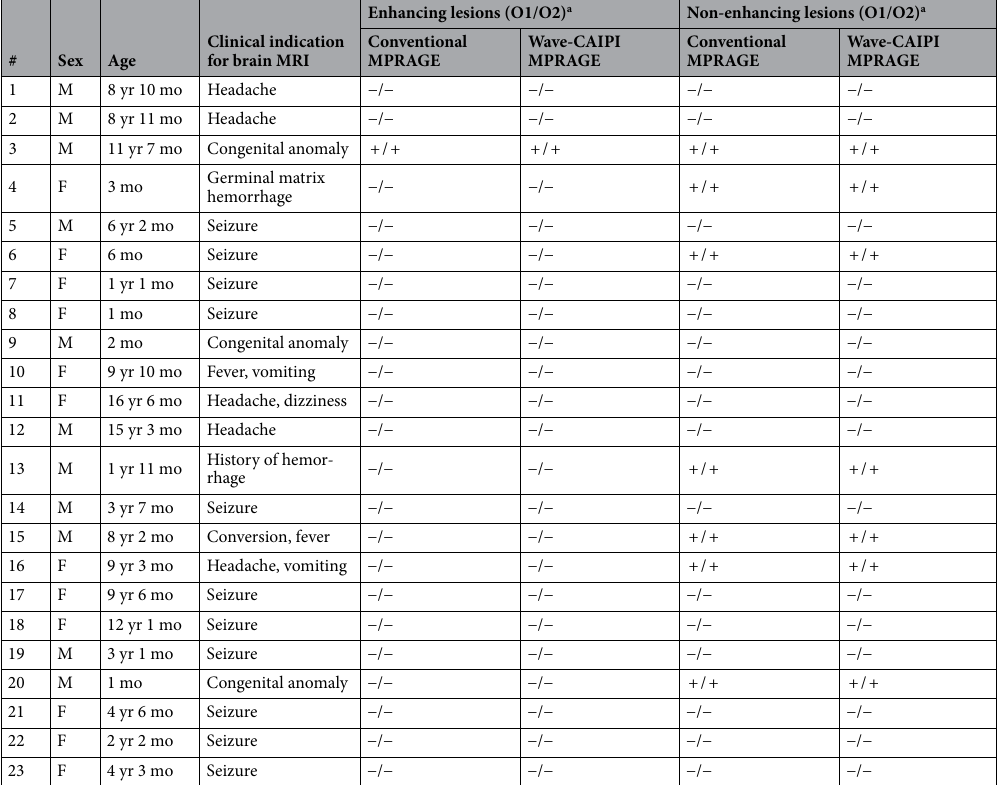
Table 2. Summary of study population. a O1/O2 indicates observer 1 / observer 2. Presence of lesion is indicated as + and absence of lesion is indicated as